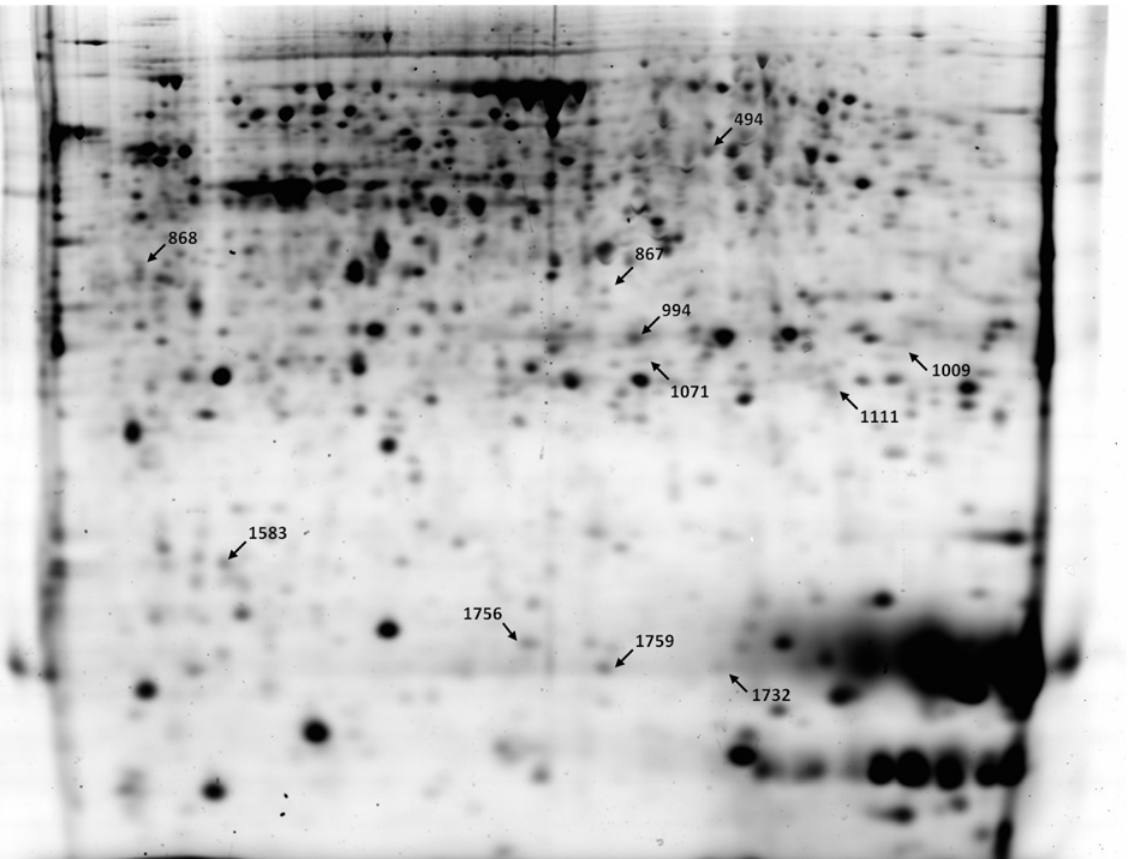
Fig 2. Representation of 2D-DIGE gel at Day 14. Proteins picked for identification are outlined with an arrow and the tagged numbers correspond to the same ones indicated in Table 2.